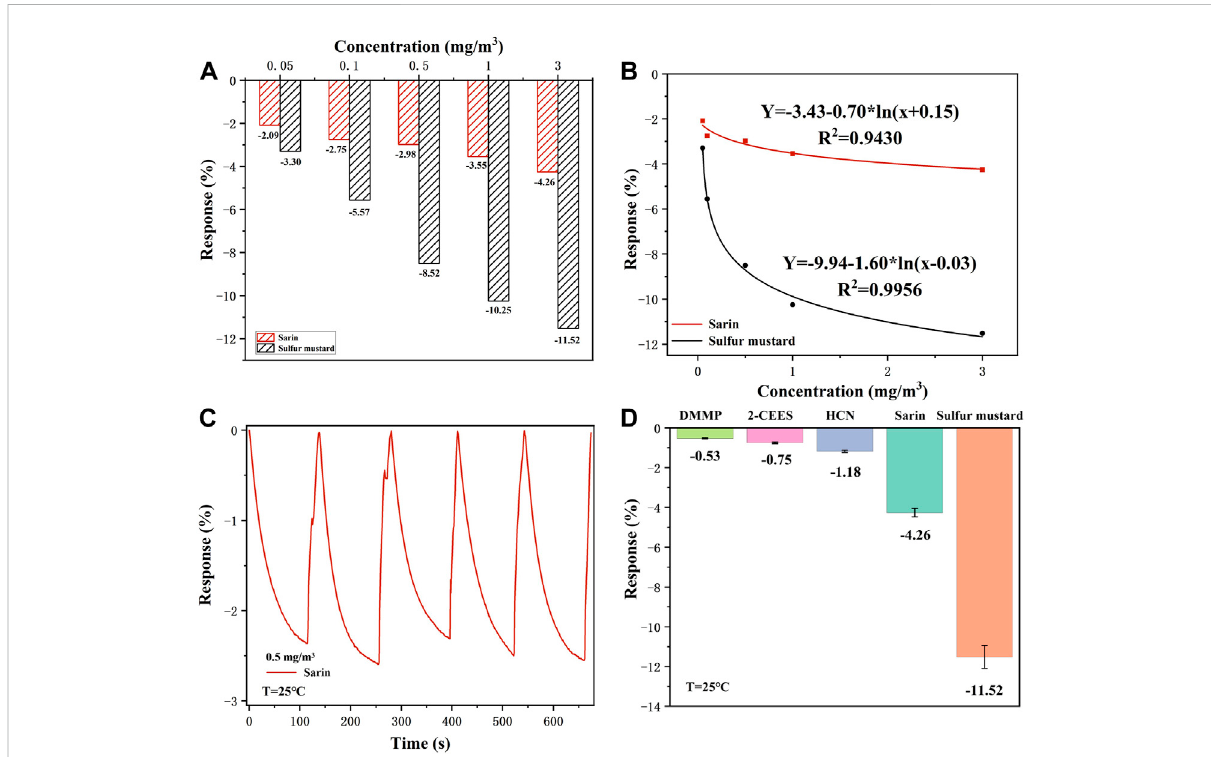
FIGURE 7 (A) The selectivity of the Nb-MoS 2 NSs-based gas sensor for sarin and mustard in this concentration range. (B) A fi tting equation between the response value and concentration of sarin and sulfur mustard. (C) Five successive sensing cycles of the Nb-MoS 2 NSs-based gas sensor was continuously exposed to 0.5 mg/m 3 sarin. (D) The selectivity of Nb-MoS 2 NSs-based gas sensor to 3.0 mg/m 3 and other analytes with 5 ppm